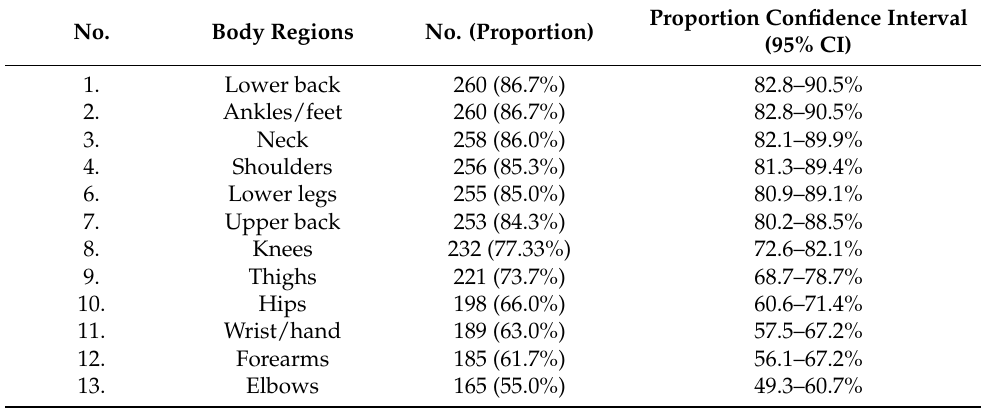
Table 2. Prevalence of WRMSDs.